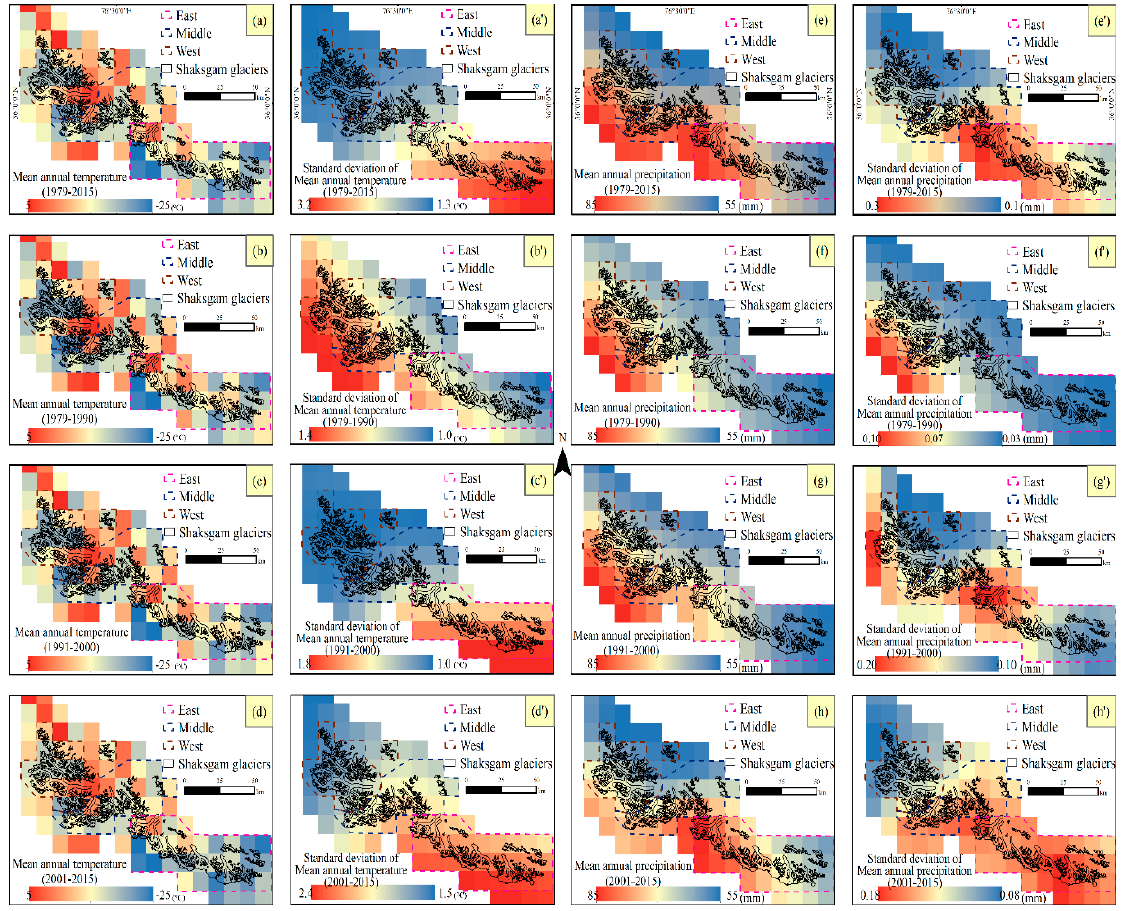
Figure 18. Mean annual temperature ( a – d ), standard deviation of mean annual temperature ( a’ – d’ ), mean annual precipitation ( e – h ) and standard deviation of mean annual precipitation ( e’ – h’ ) in the Shaksgam Valley during 1979–2015.